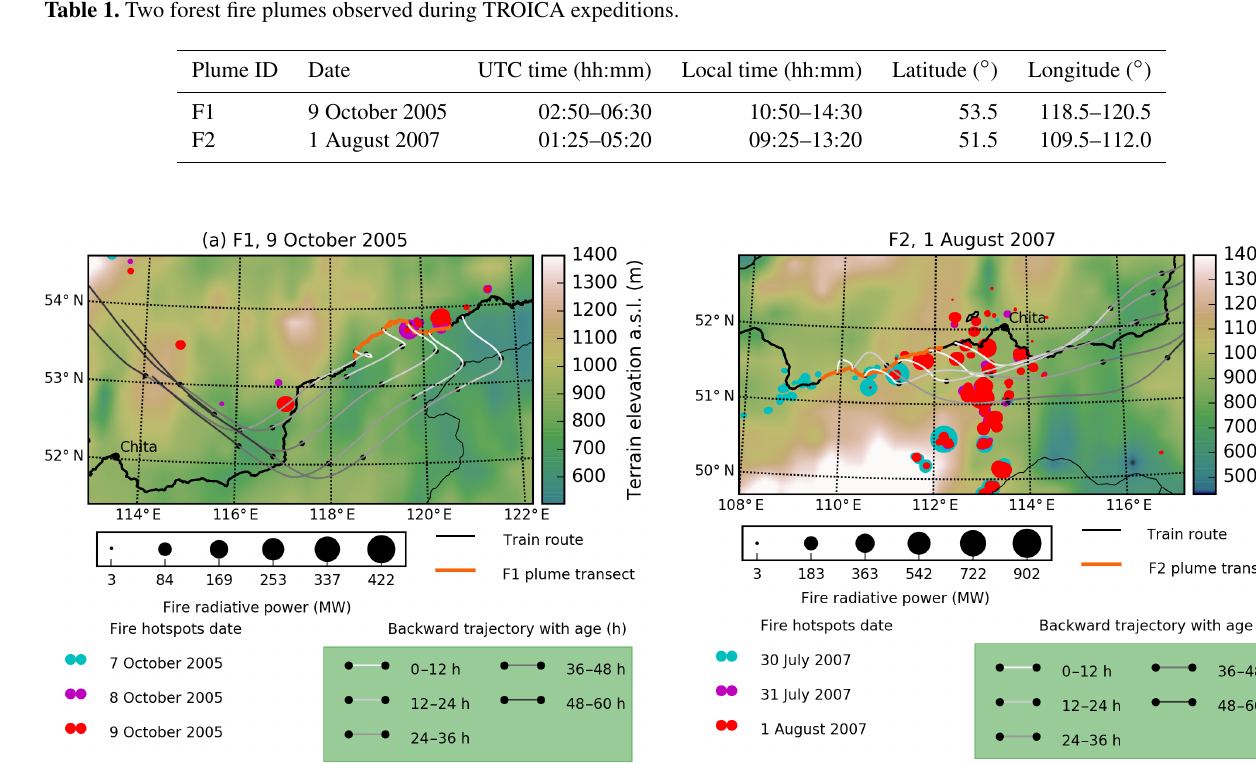
Table 1. Two forest fire plumes observed during TROICA expeditions.